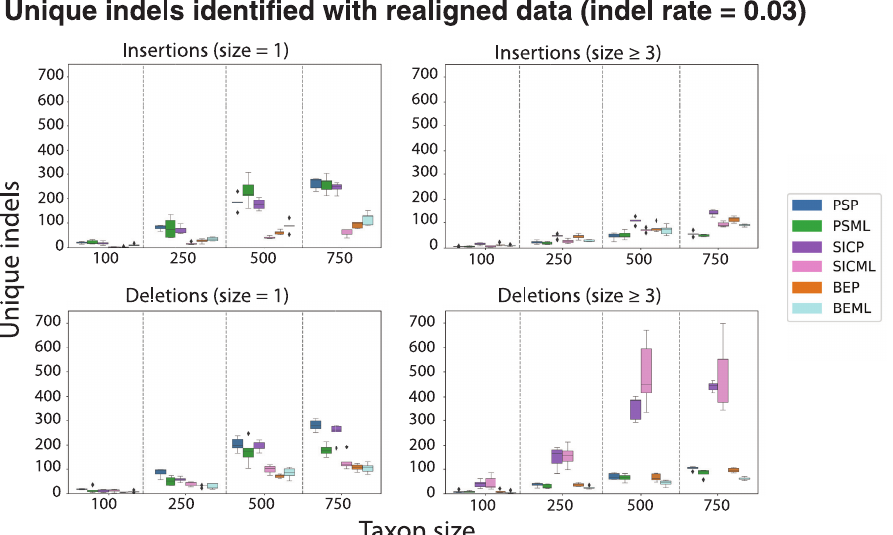
Fig 2. Results of indel evaluation of each of GRASP’s indel methods across 1) simulated data where the correct alignment and correct tree are supplied and 2) simulated data where a realigned alignment and correct tree are supplied across four indel rates (0.001, 0.005, 0.01, 0.03) and four taxon sizes (100, 250, 500, 750). A , Number of correct indels identified by each method for each taxon size for each indel rate ( N = 5). B ,Number of indels uniformly identified by all methods or uniformly missed by all methods for each taxon size for each indel rate ( N = 5). C ,Number of indels uniquely identified by each indel method at four taxon sizes at indel rate 0.03, organised by indel type and size ( N = 5).